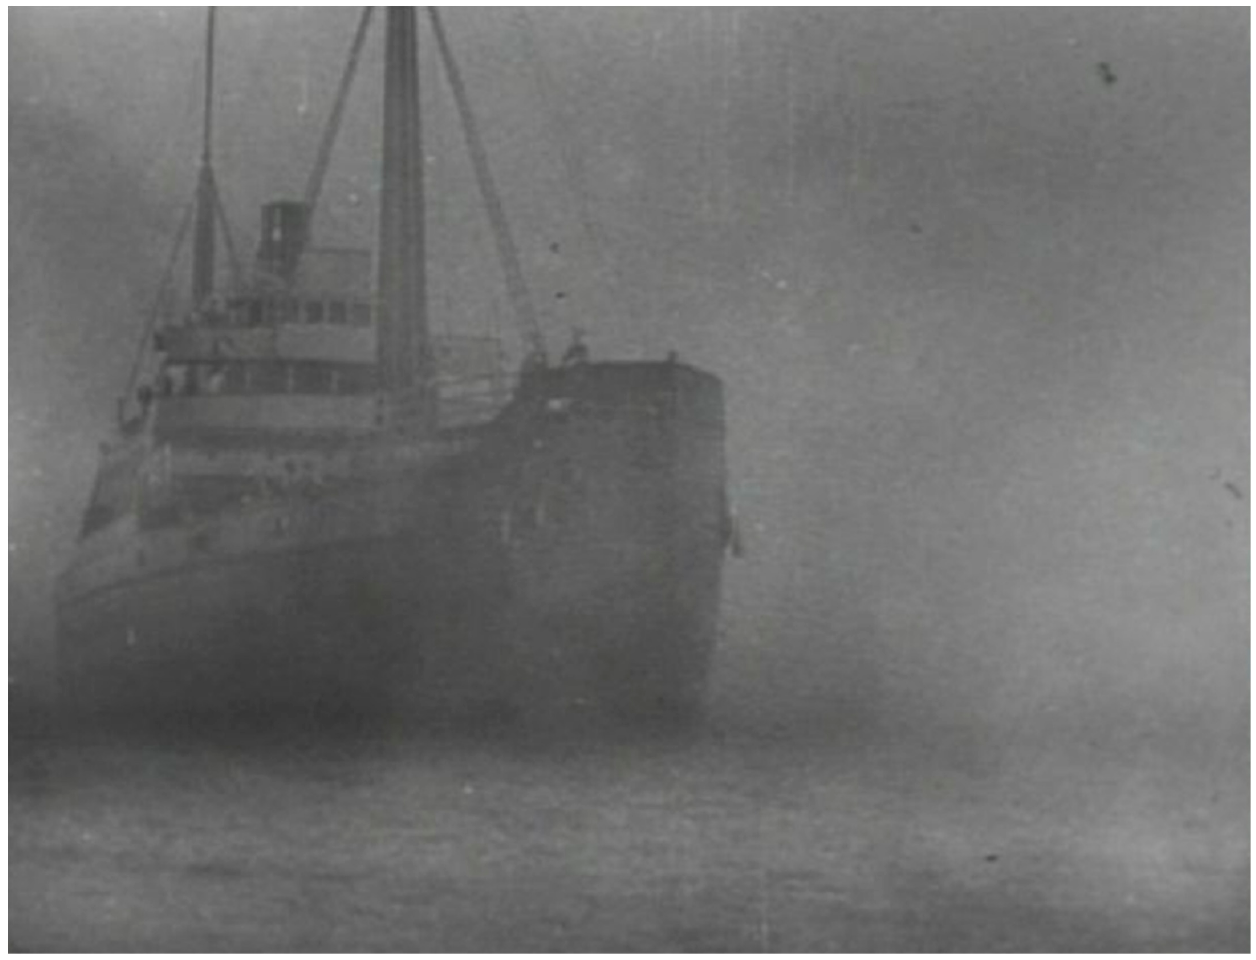
Figure 1. The island of perpetual mist (1933). https://www.pinterest.com/pin/265923552967922496/ (accessed on 1 January 2021).